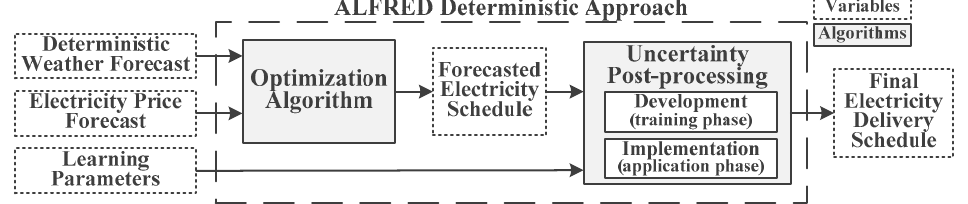
Figure 1. Artificial learning flexible renewable energy system dispatch (ALFRED) deterministic dispatch planning tool: a partitioned approach of an optimization algorithm with the machine learning uncertainty post-processing (which includes a development and an implementation phase).